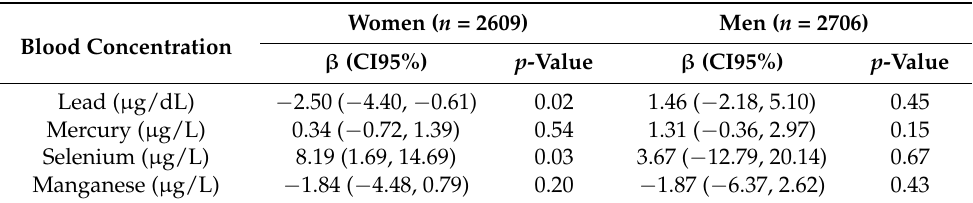
Table 6. Change in grip strength for a 10-fold increase in the concentration of blood elements, from models including all four